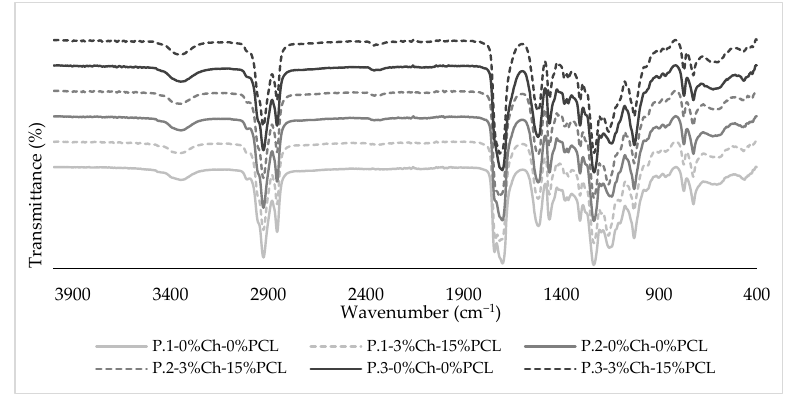
Figure 2. FTIR spectra of the synthesized PUs.